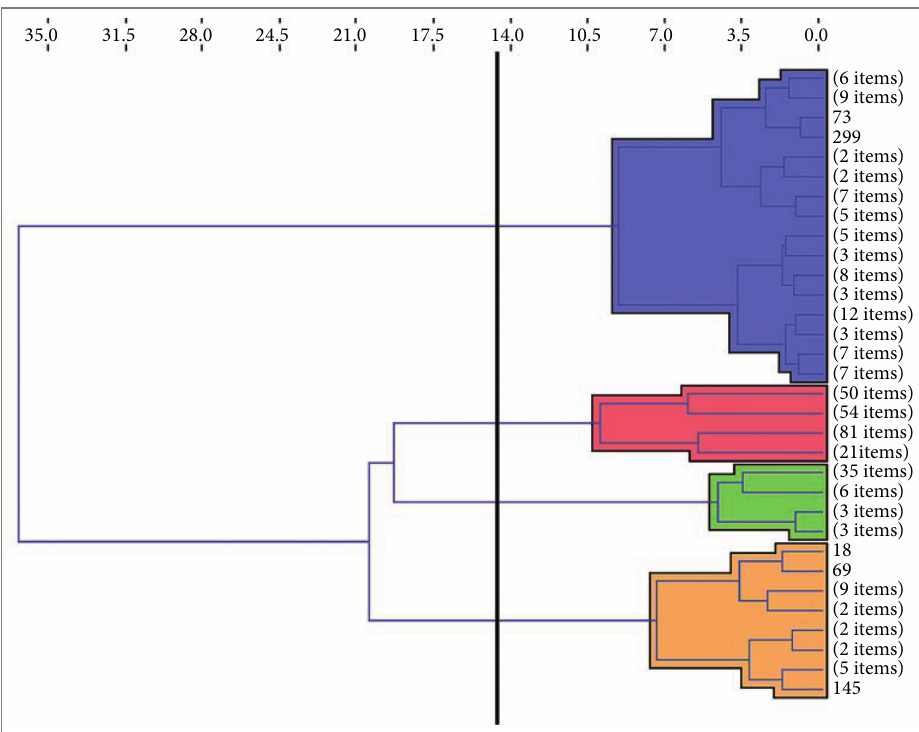
Fig. 6. Examples of class B are grouped into clusters. Optimal number of clusters – 4 (cut-off line at height